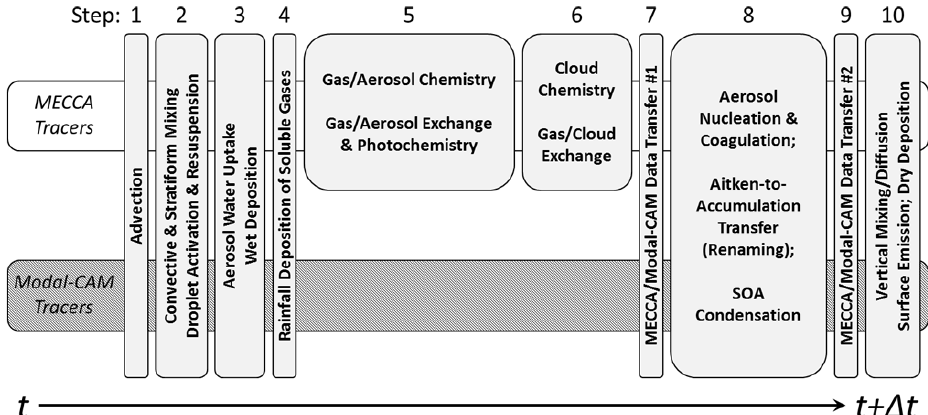
Fig. 1. Schematic showing the order of relevant chemistry, dynamics and physics routines (light gray boxes) over a single model time iteration ( 1t) relative to the MECCA (white horizontal bar) and the modal-CAM (gray dark-gray horizontal bar) tracer arrays. Boxes indicating model operations are oriented vertically across the tracer array bars to indicate whether they interact with one or both tracer arrays. Step indices correspond to those described in the text (see Sect.